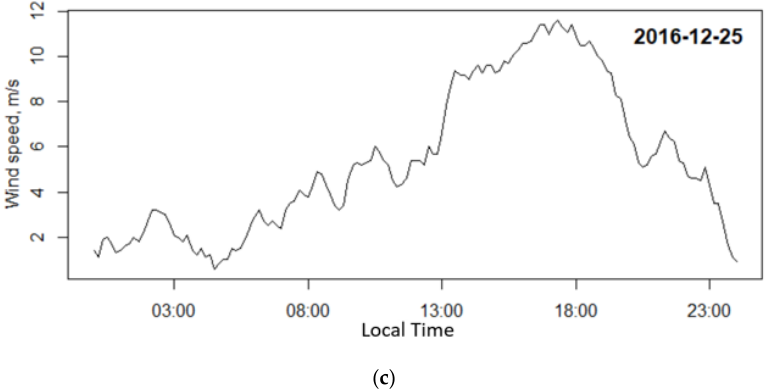
Figure 8. ( a ) The wind speed diurnal variation patterns of individual months; ( b ) and ( c ) hourly wind speed of 25 August and 25 December 2016, respectively. After the nonstationary periodic components were identified, they were removed from the observed wind speed series, and the residual series was treated as an ARMA